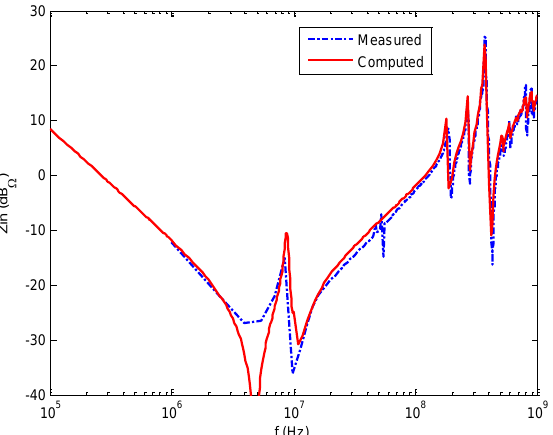
Figure 17. Comparison between the measured and computed values of the input impedance at the port P of the PDN board with the decaps placed as in Figure 16.